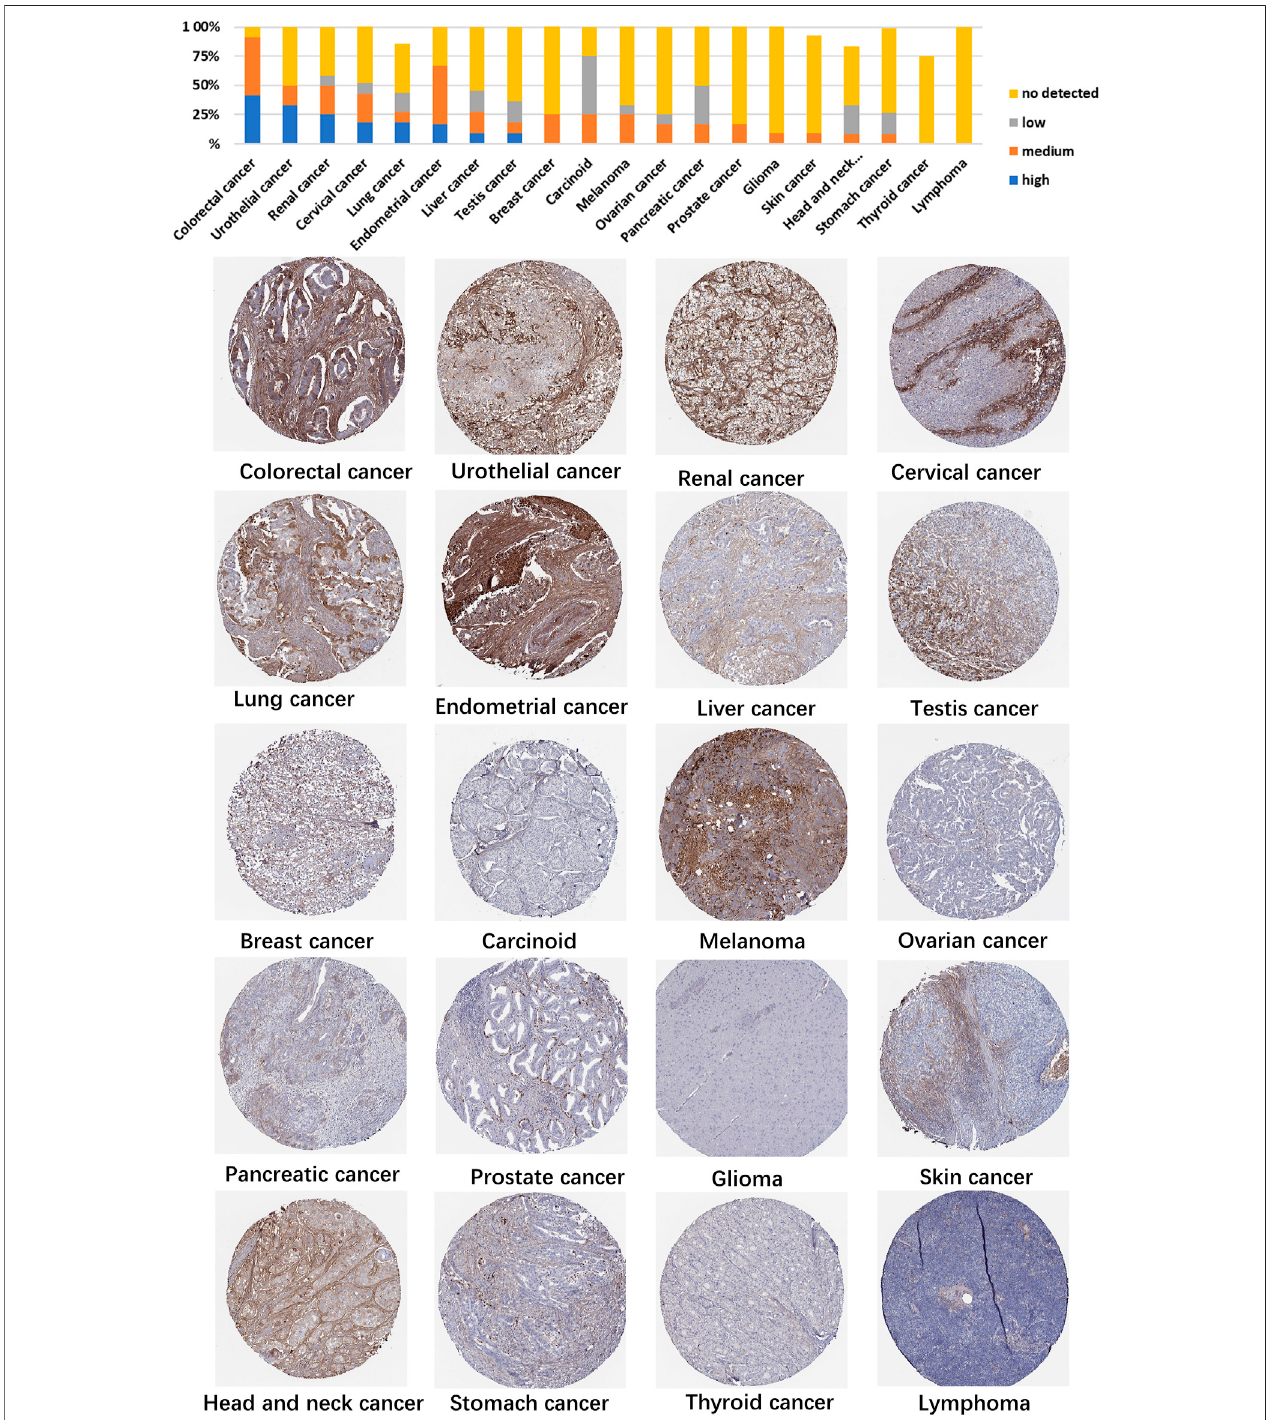
FIGURE 2 | Representative immunohistochemical staining of TGFBI protein in various cancer tissues.